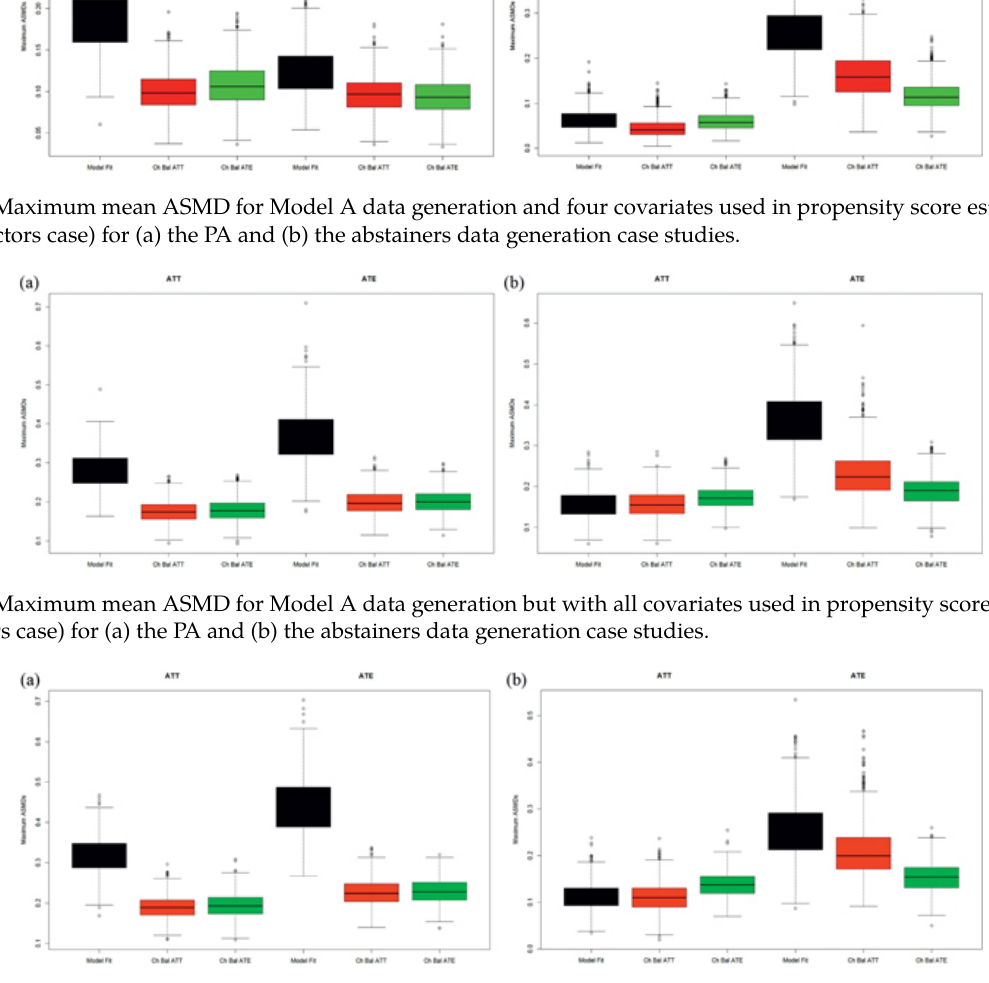
Figure 4: Maximum mean ASMD for Model B data generation and Model B propensity score estimation (All important case) for 4 most influential covariates for (a) the PA and (b) the abstainers data generation case